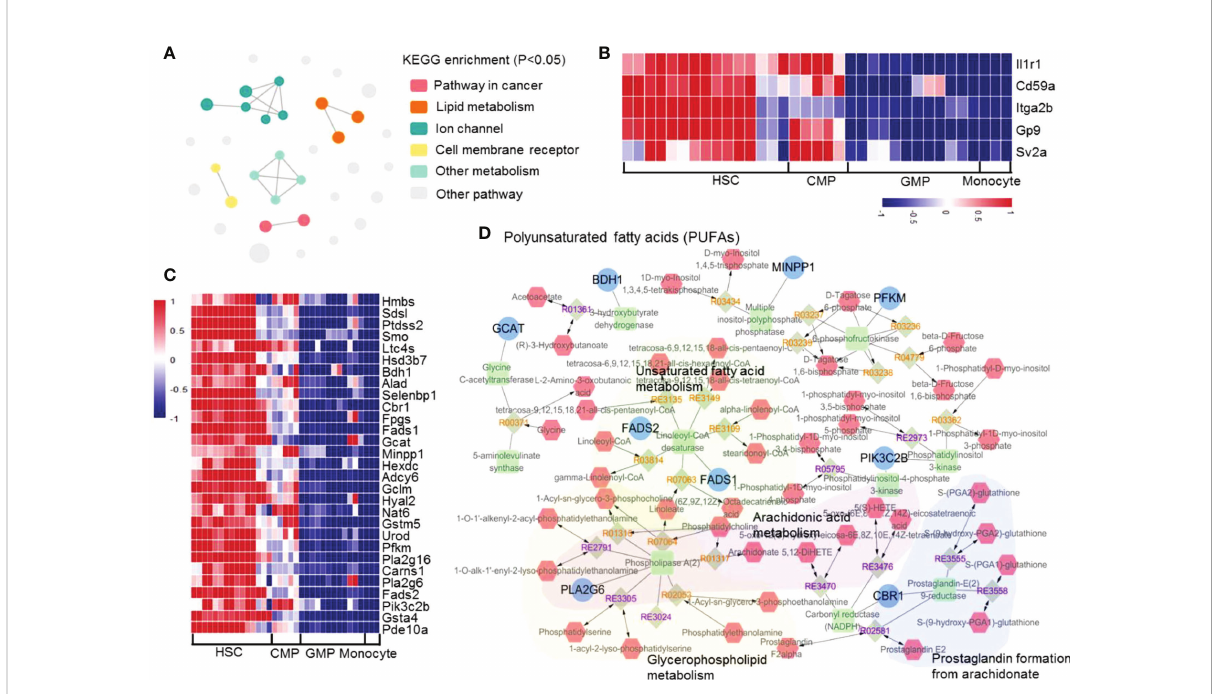
FIGURE 6 The signi fi cantly downregulated genes in mouse monocyte development. (A) Enrichment network of the upregulated transcription factors and pathways in the differentiation of HSCs into monocytes. Each node represents an enriched term, and the node color represents different clusters; the node size represents 6 levels of enriched p-values. (B) Heatmap of the downregulated genes in hematopoietic cell lineage pathway. (C) Heatmap of the downregulated genes in lipid metabolism-related pathways. (D) Network of consistently downregulated genes enriched in metabolism